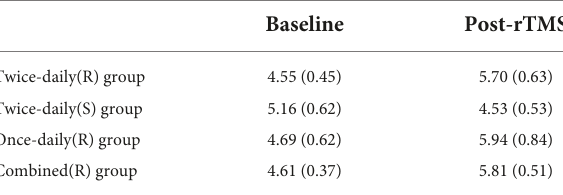
TABLE 3 Characteristics of participants from Twice-daily(R) and Once-daily(R) .